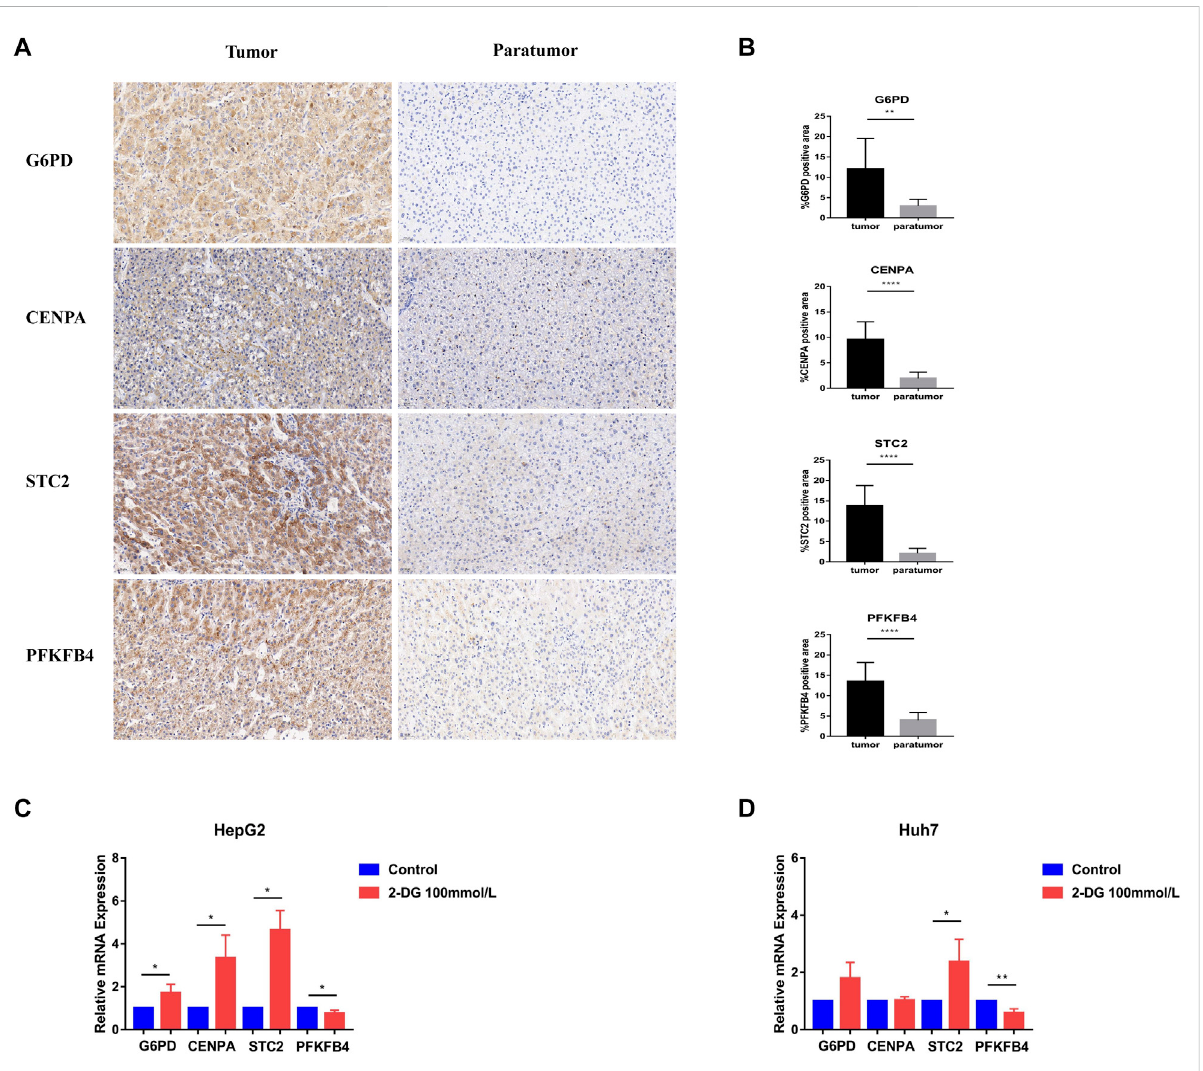
FIGURE 8 Experimentalveri fi cationofglycometabolism-relatedgenes. (A,B) ImmunohistochemistryshowedtheG6PD,CENPA,STC2,andPFKFB4genes expression and positive rate in tumor tissues ( n = 13) and adjacent tissues ( n = 13). (C,D) In HepG2 and Huh7 cell lines, G6PD, CENPA, STC2, and PFKFB4 mRNA expression levels were observed in the glycolysis inhibitor treated group (2-DG) and the control group.* p < 0.05, ** p < 0.01, *** p < 0.001, **** p <